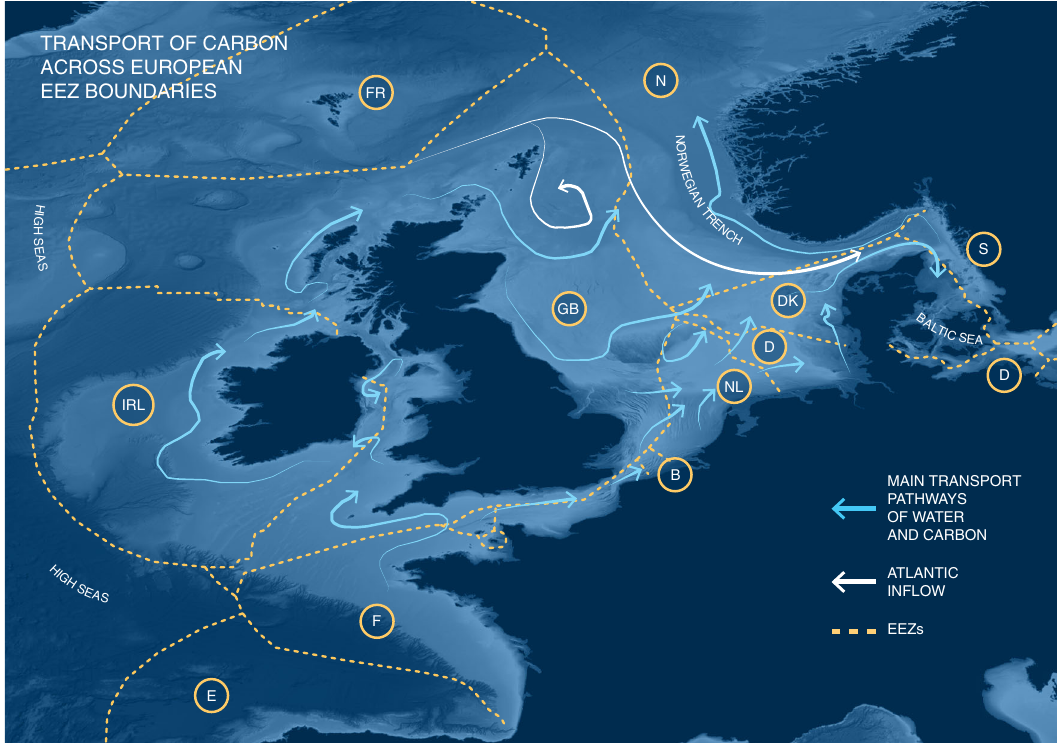
Fig. 2 Transport of carbon on the North West European shelf. Illustrating the in fl ows and transport pathways for carbon in the marine environment, including movement across agreed Exclusive Economic Zone (EEZ) boundaries between [11] countries: (FR) Faroe Islands; (GB) Great Britain; (IRL) Ireland; (F) France; (E) Spain; (B) Belgium; (NL) Netherlands; (D) Germany; (DK) Denmark; (S) Sweden; (N) Norway. Source for coordinates of EEZ boundaries: http://www.marineregions.org/eezmapper.php. The main transport pathways on the North West European shelf 11,26,67 are based on the main water fl ow (residual pathways), which will transport particulate and dissolved forms of carbon and sediment. The fl ows are largely driven by tides, wind driven transport, and density driven fl ows driven by temperature and salinity differences or by Atlantic in fl ow (white). They vary in strength, rate and depth depending on season and many cross national EEZ boundaries. EEZ 17 and bathymetry (blue scale) from http://portal.emodnet-bathymetry.eu/#. Adapted from Hill et al. 26 and Luisetti et al. 66